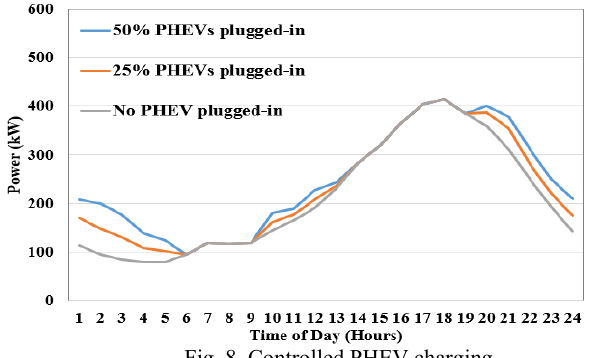
Fig. 8. Controlled PHEV